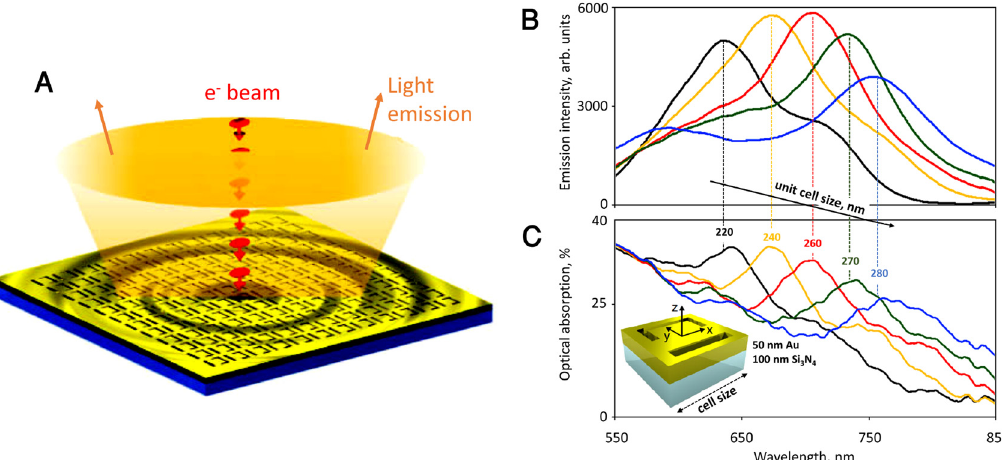
Figure6: (A)Highlylocalizedelectronbeamexcitationatthecenterofametamaterialarrayleads,viastrongcouplingamongmetamolecules, to the collective oscillation of many cells and thereby the emission of a free-space light beam. (B) Electron beam – induced metamaterial light emissionspectraforarrayswithdifferentmetamoleculessize(aslabeled).(C)Correspondingopticalabsorptionspectra.Theinsetto C shows a schematic of the asymmetric split-ring metamolecules